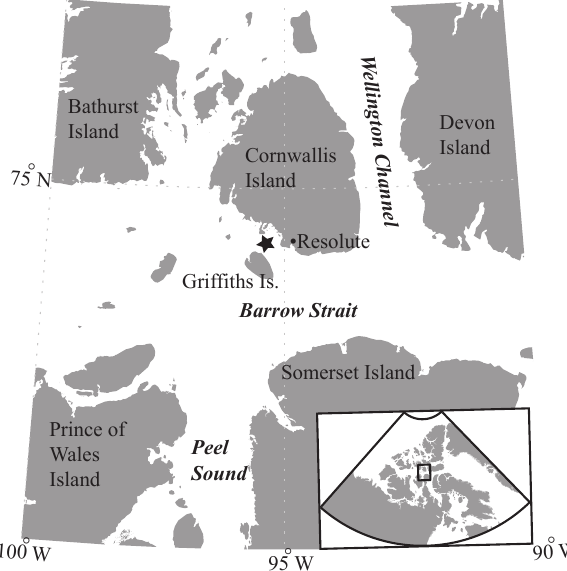
Figure 1. Location map of the sampling area in the Resolute Pas- sage, Nunavut. The sampling site was located between Sheringham Point and Griffith Island (74 . 726 ◦ N, 95 . 576 ◦ W).